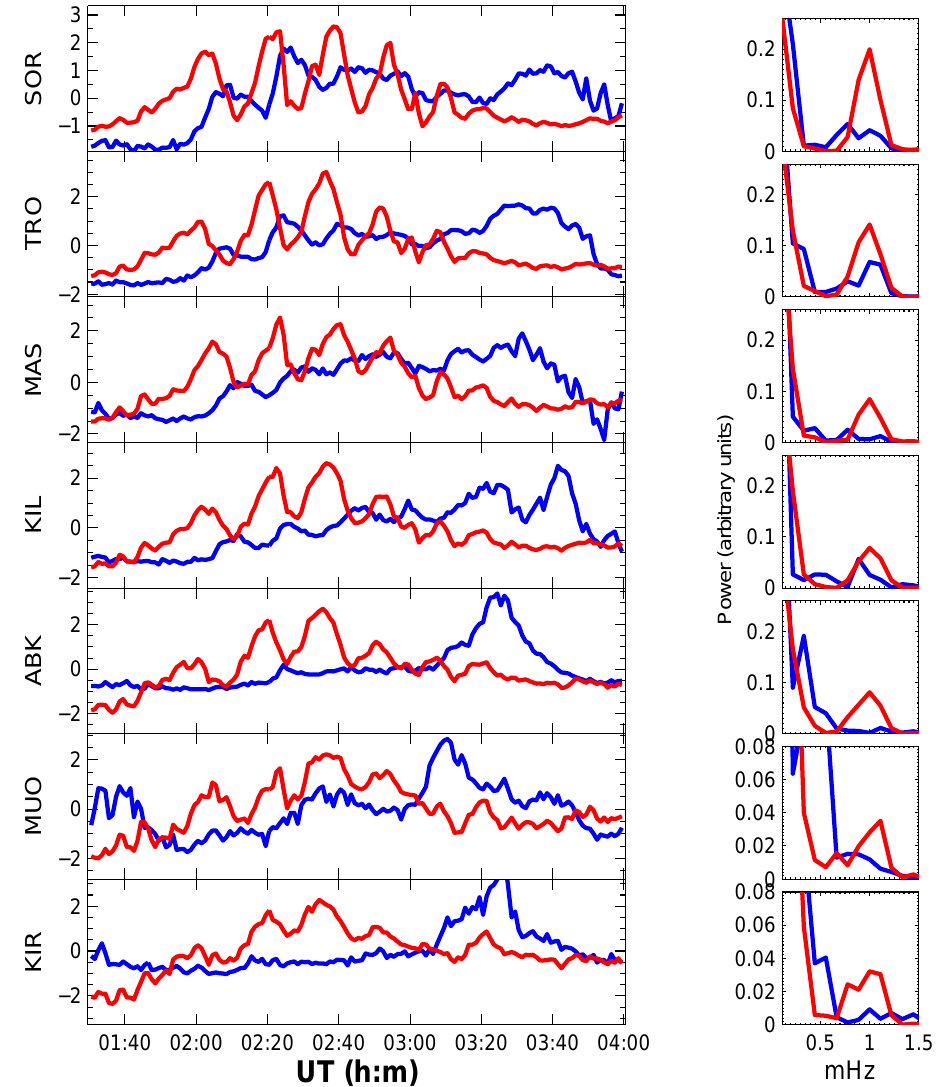
Fig. 4. Comparison of the co-located riometer (blue) and magnetometer (red) Y-component data. The data in the left hand column have been normalized to units of standard deviation to ease comparison (subtract the mean for each time series and divide by the standard deviation). The results of a Fourier analysis of the interval are in the right-hand column showing the power from 0 to 1.5mHz. Note the change in power scale at MUO and